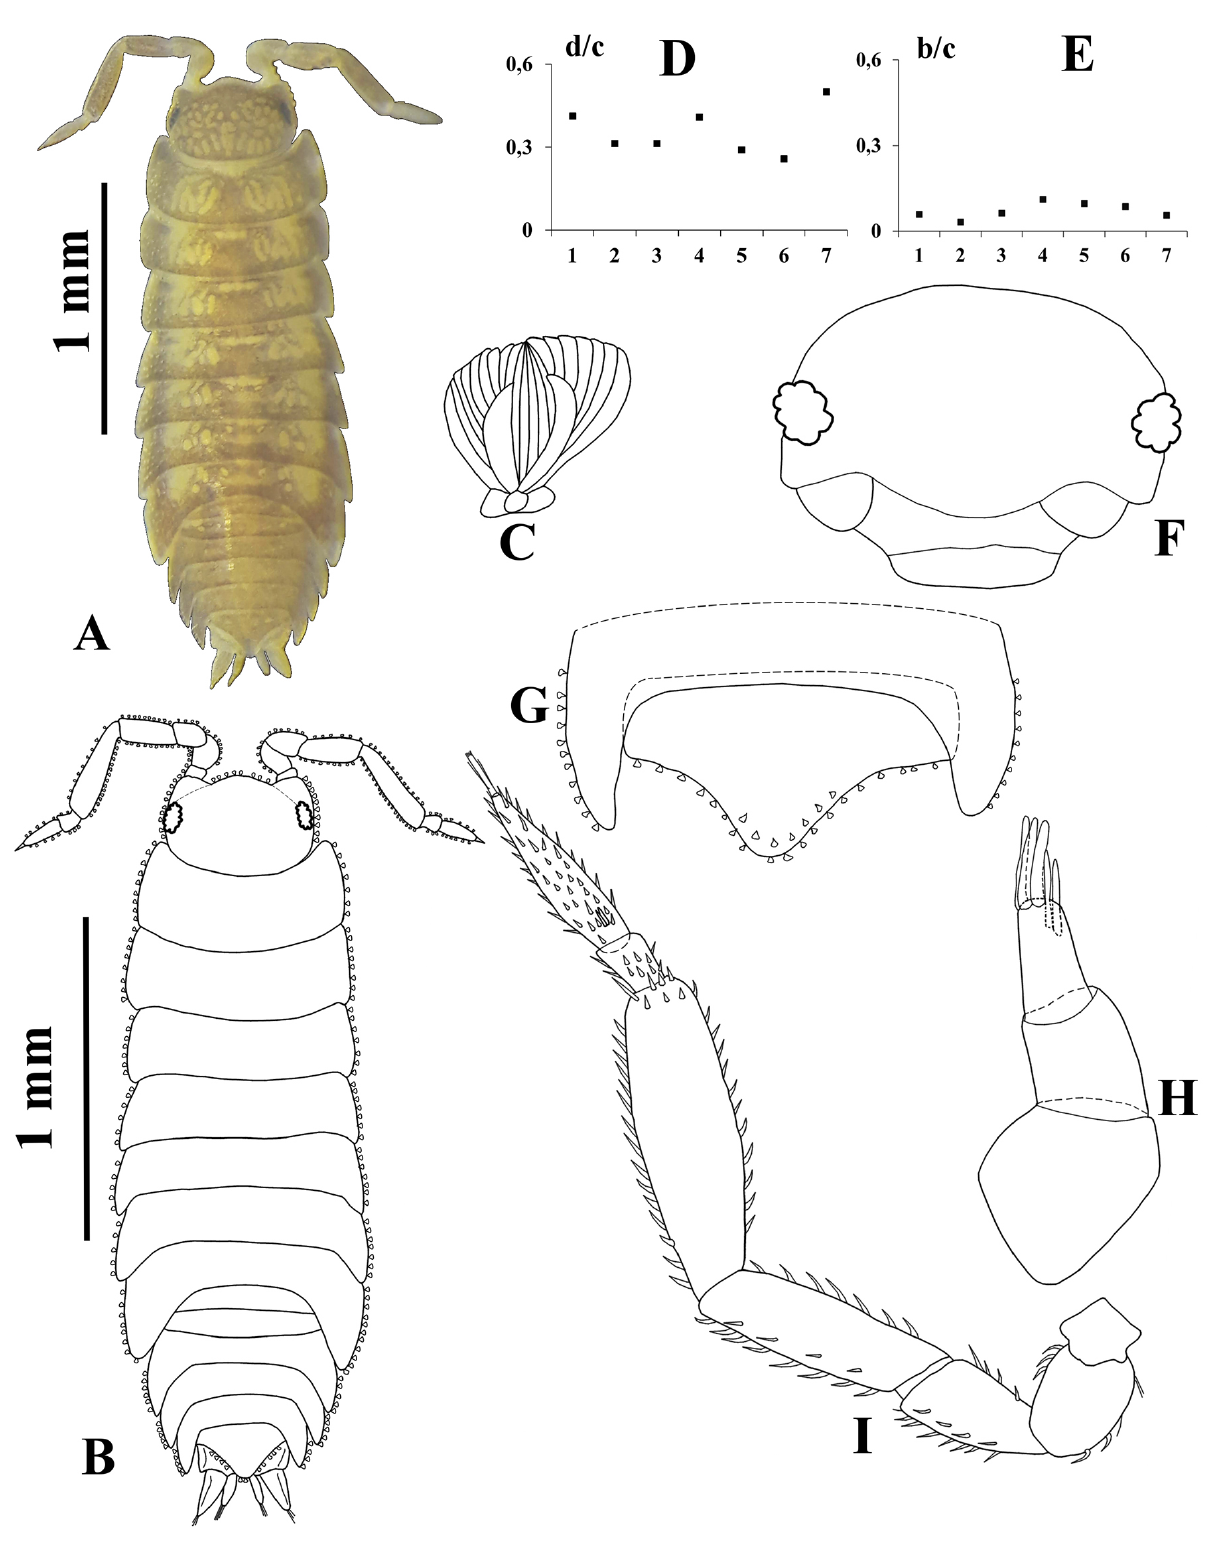
Figure 1. Trichorhina navasi López-Orozco, Carpio-Díaz and Campos-Filho n. sp., (male paratype). A, B , habitus, dorsal view; C, dorsal scale-seta; D , b/c noduli laterales coordinates; E , d/c noduli laterales coordinates; F , cephalon, dorsal view; G , pleonite 5 and telson; H , antennula; I ,